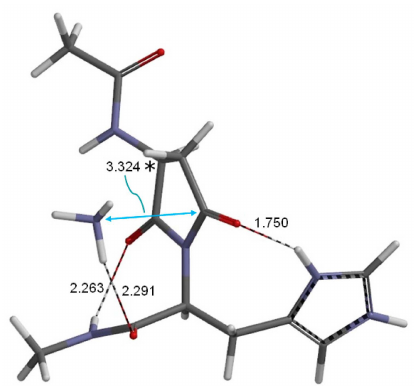
Figure 8. The optimized geometry of the product complex PC (complex between the SI product and an NH 3 molecule) ( ϕ N = ´ 163 ˝ , ψ N = ´ 147 ˝ , χ 1N = 146 ˝ , ϕ H = ´ 80 ˝ , ψ H = 91 ˝ , χ 1H = ´ 56 ˝ ). The imidazole ring is in the cationic form. Relevant interatomic distances are shown in Å. The asterisked carbon corresponds to the Asn α carbon in the reactant R.